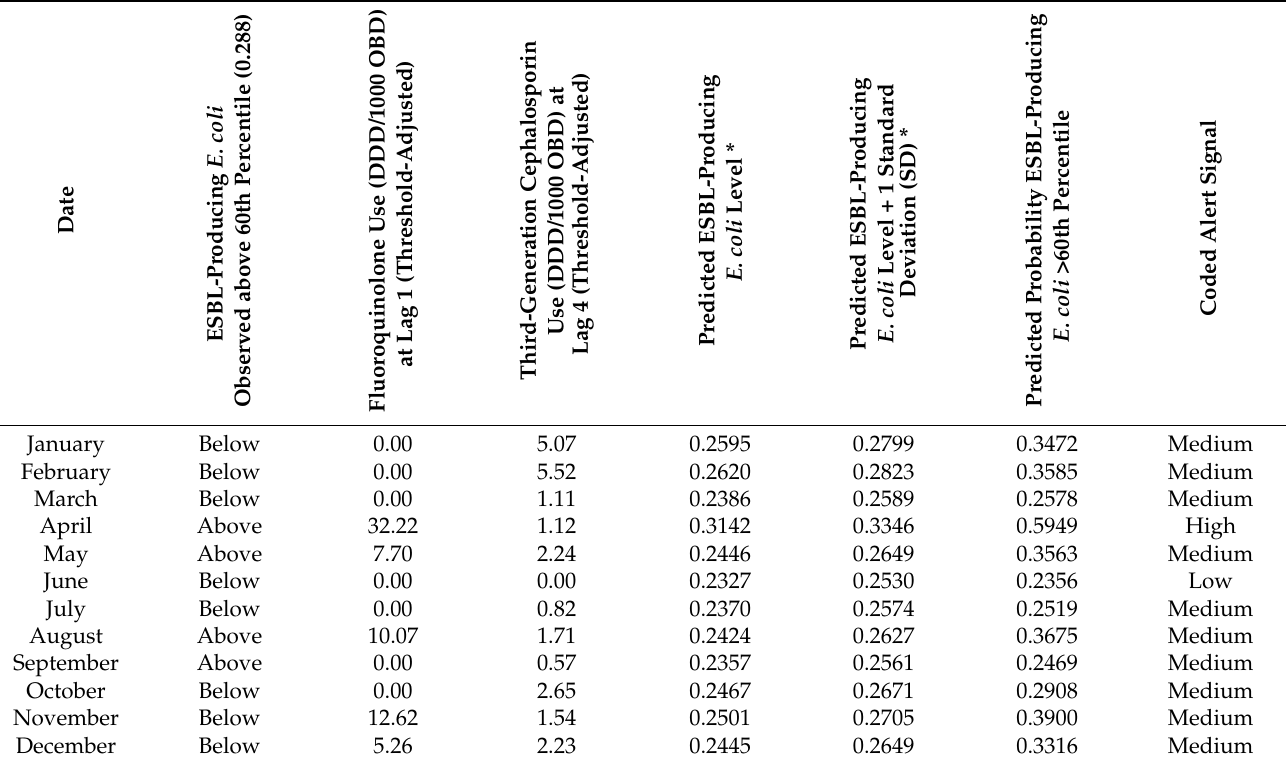
Table 2. Risk scores for ESBL-producing E. coli incidence rate exceeding the 60th percentile for 2021.